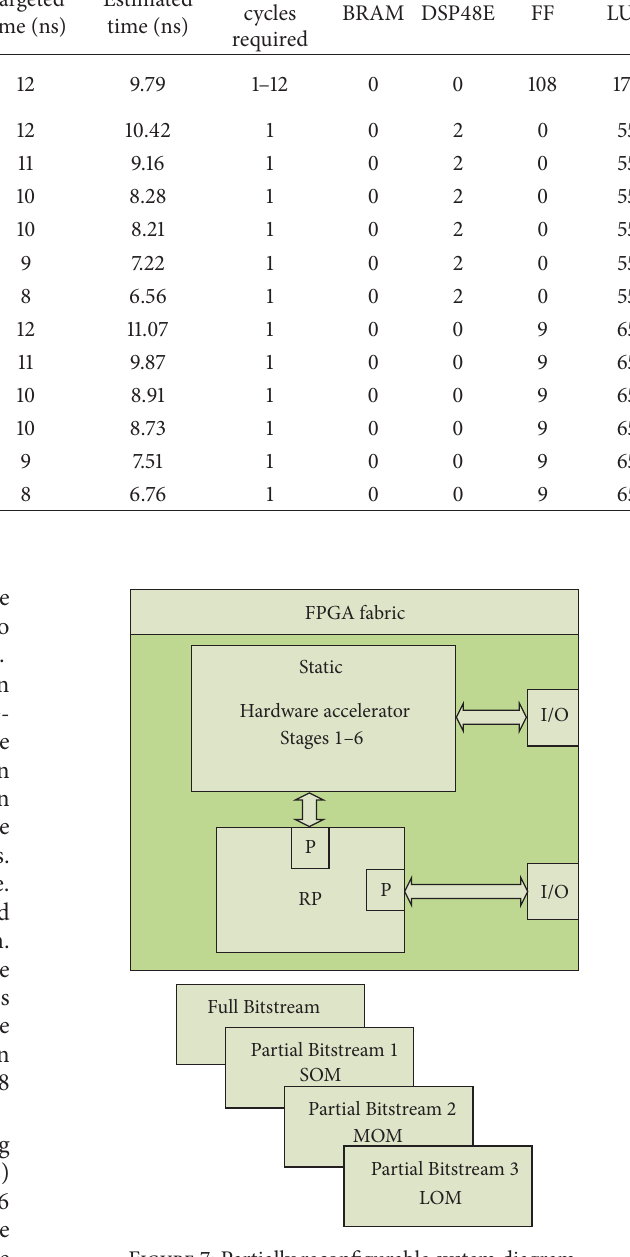
Figure 7: Partially reconfigurable system